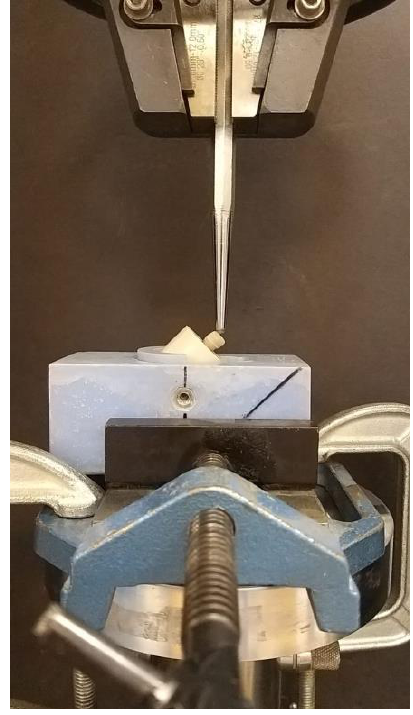
Figure 2. Fracture resistance evaluation with a universal testing machine.